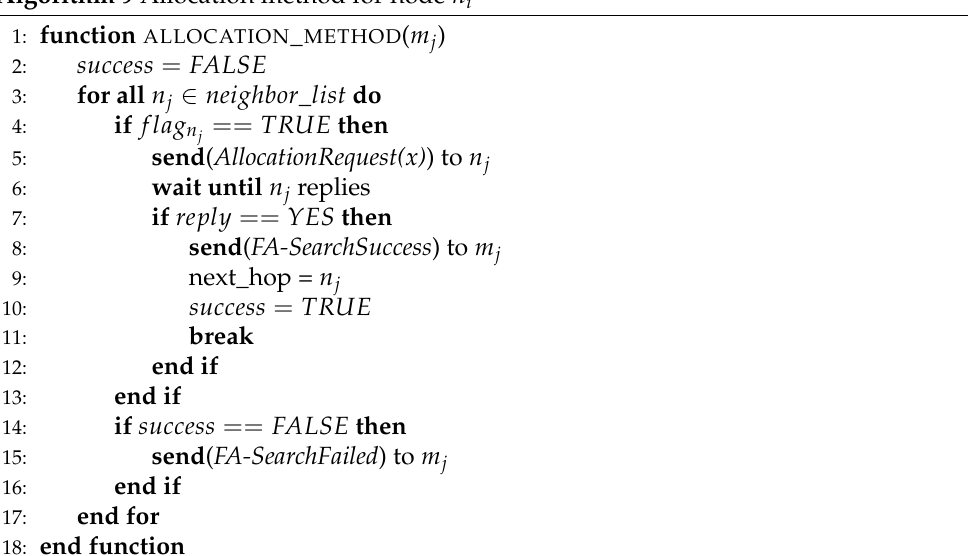
Algorithm 9 Allocation method for node n